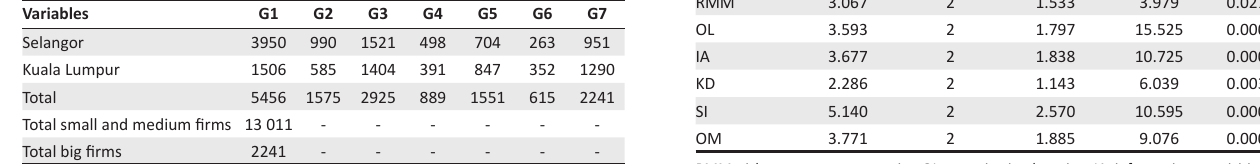
TABLE 1: Active construction companies in Kuala Lumpur and Selangor states. Variables